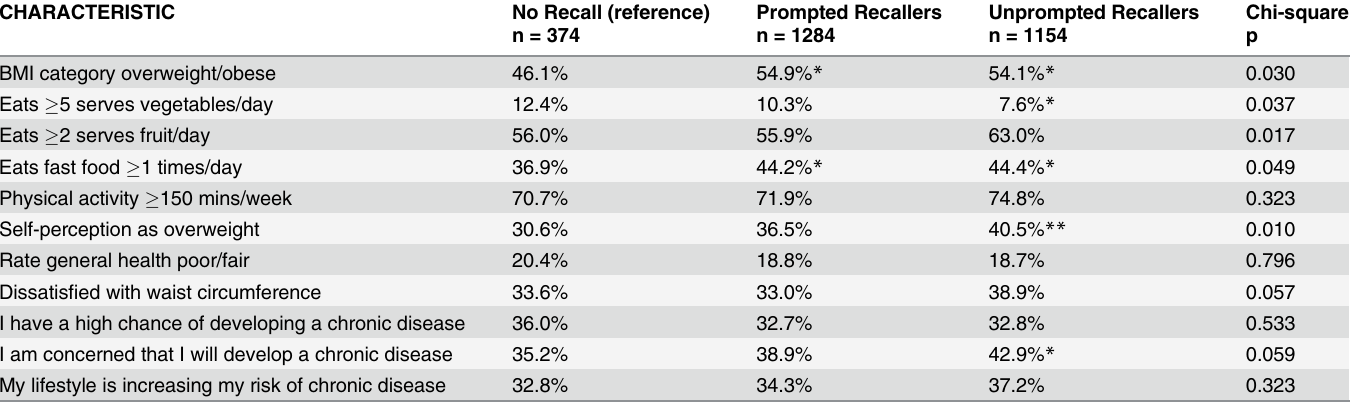
Table 4. Risk profile and risk perceptions for each level of Measure-Up campaign